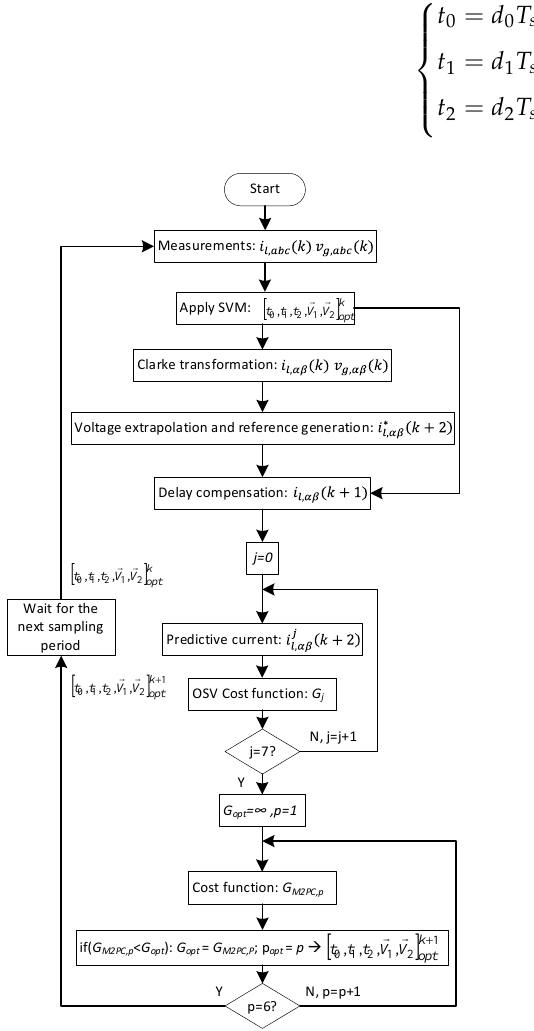
Figure 8. Developed flowchart of the M2PC.